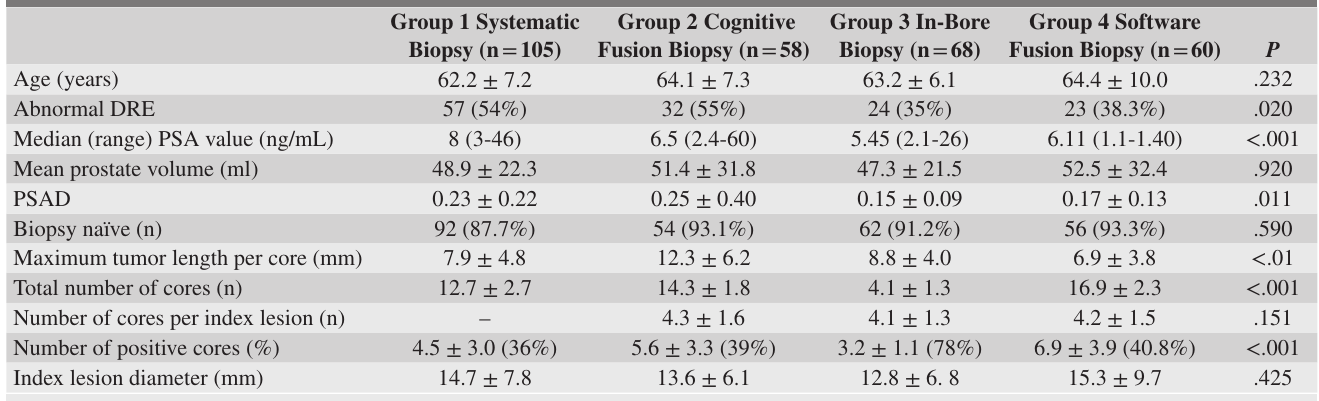
Table 1. Summary of the Clinical Characteristics of the Study Cohort